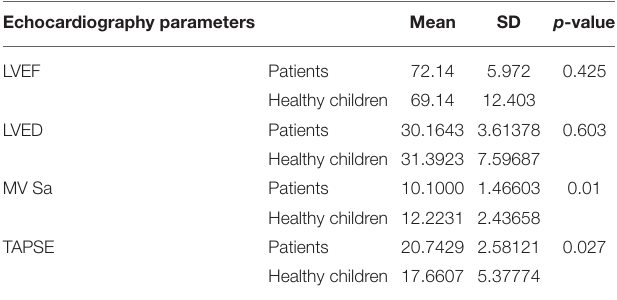
TABLE 3 | Echocardiography parameters among COVID19 patients and healthy children. Echocardiography